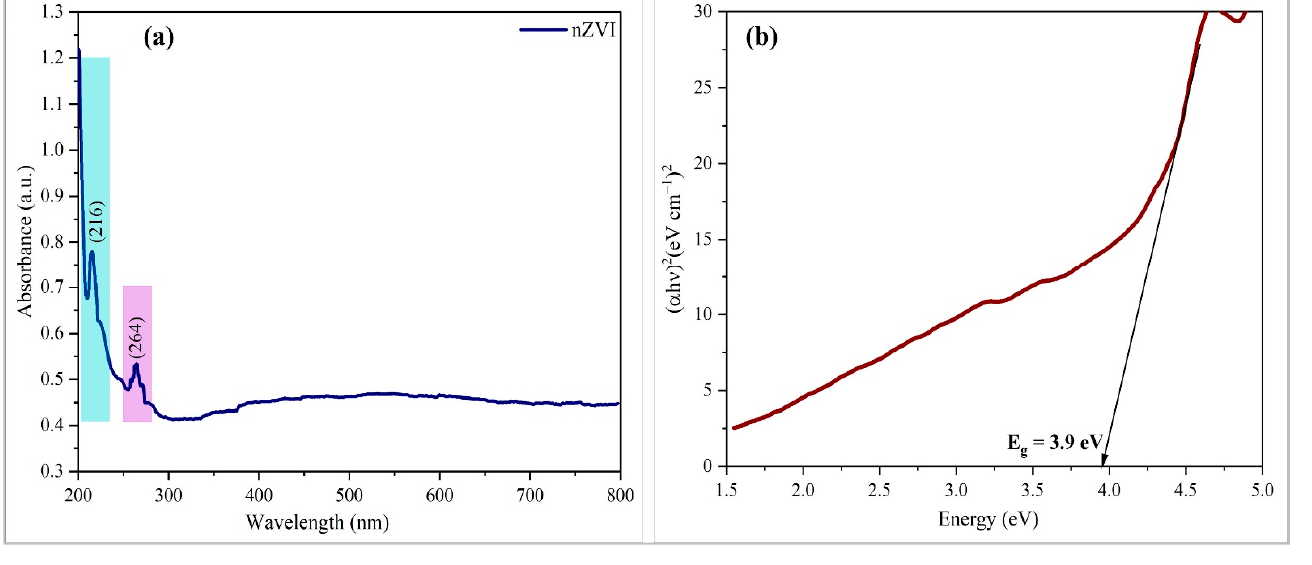
Figure 1. ( a ) UV–vis spectra of synthesized nZVI particles. ( b ) Tauc plot of synthesized nZVI particles.